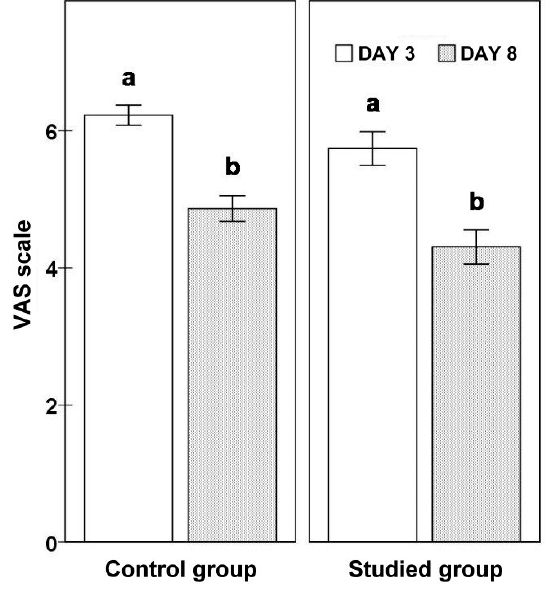
Figure 6. Evaluation of the knee joint flexion angles in the treatment and clinical control groups.